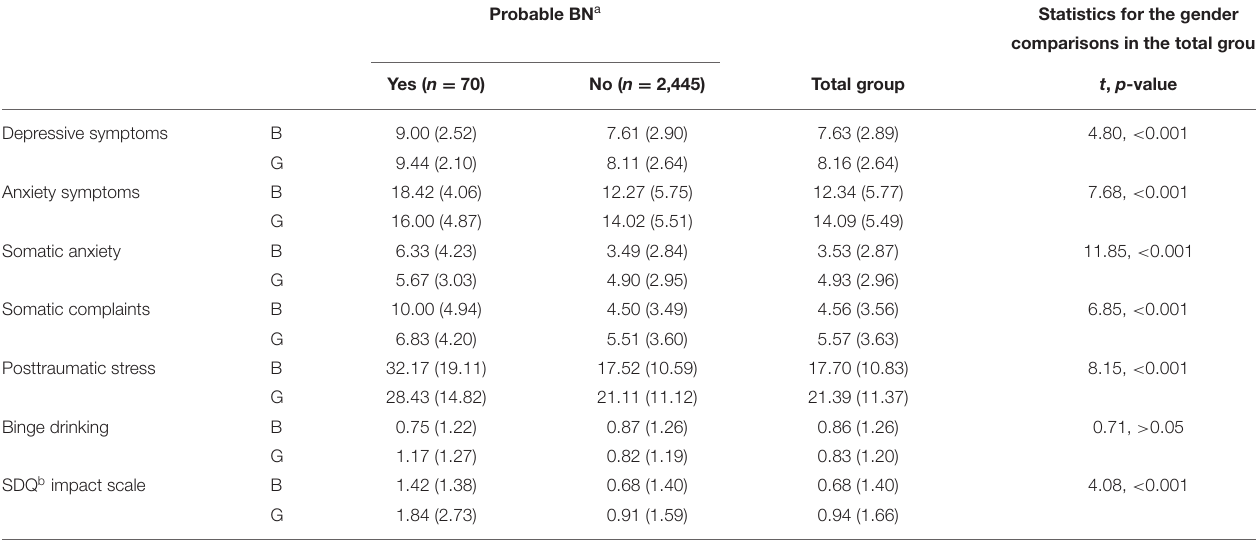
TABLE 2 | Problem scores [M (SD)] by bulimia symptoms in boys (B) and girls (G).